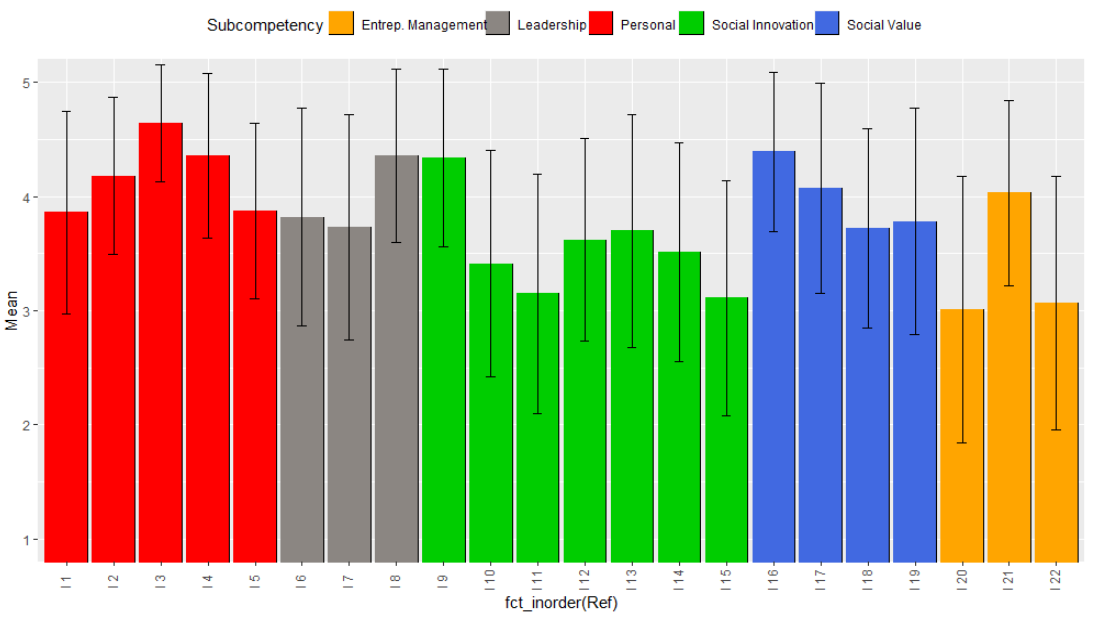
Figure 1. Bar chart. Arithmetic mean and standard deviation of indicators by subcompetencies. Source: Created by the authors.